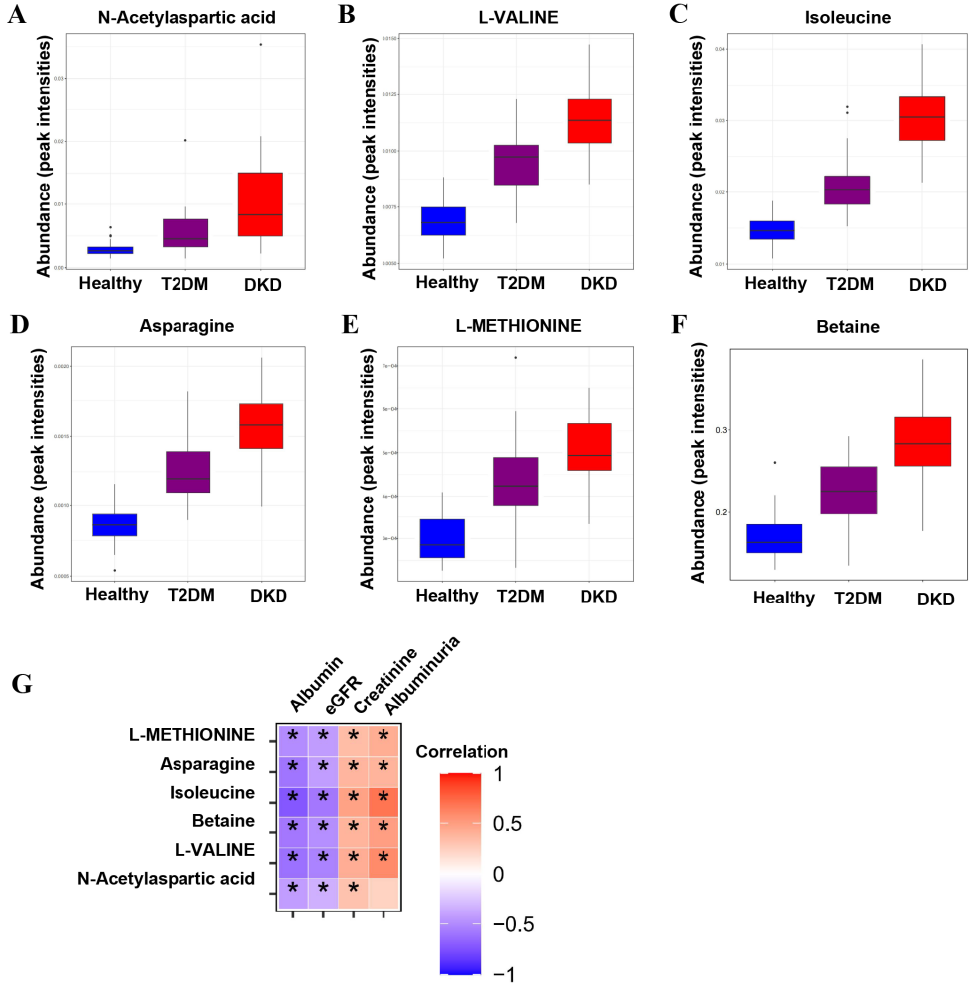
Figure 2. Metabolic differences across the Health–T2DM–DKD gradient. ( A – F ) Differential metabolites among Health, T2DM, and DKD groups, including the relative intensities of the six up-regulated overlapping metabolites from Health to T2DM and towards DKD. ( G ) The correlations between differential metabolites and clinical parameters. Significant p -value < 0.05. * p < 0.05. Table 2. Correlation analysis between clinical parameters and